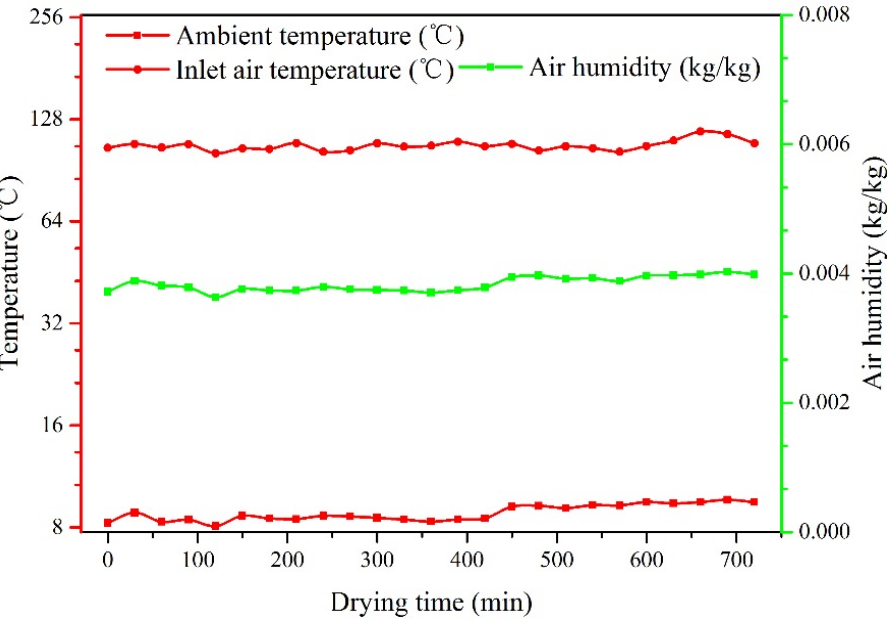
Figure 5. Ambient and medium conditions during drying process.